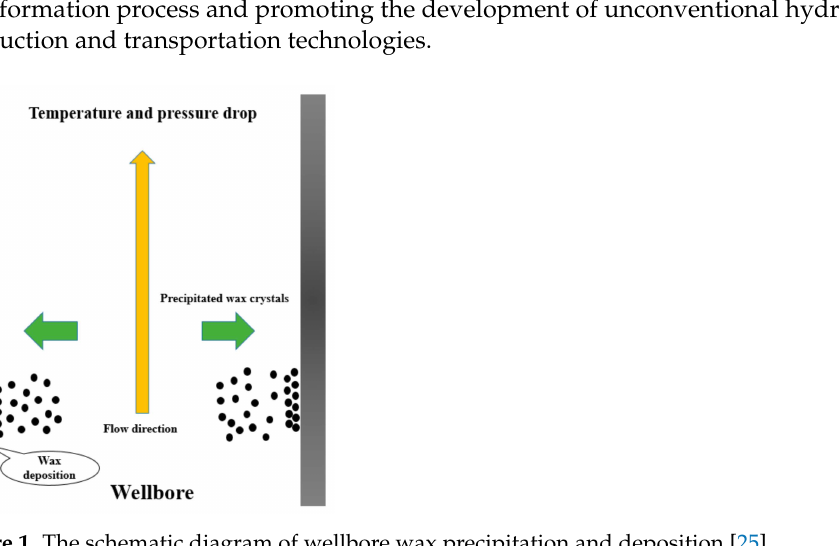
Figure 1. The schematic diagram of wellbore wax precipitation and deposition [25].